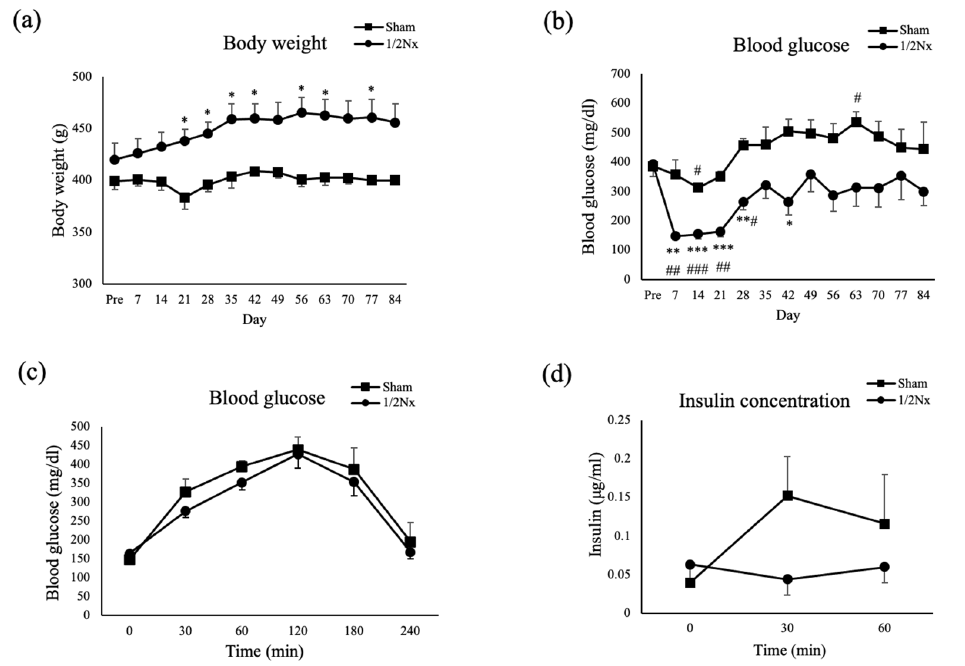
Figure 4. The changes of body weight and blood glucose after surgery and oral glucose tolerance test at 28 days after surgery. ( a , b ) Postoperative changes in ( a ) body weights and ( b ) blood glucose concentrations of Sham operated ( n = 3) and 1/2Nx ( n = 6) rats. * p < 0.05, ** p < 0.01, *** p < 0.001 between the two groups. # p < 0.05, ## p < 0.01, ### p < 0.001 compared with preoperative value in the same group. ( c , d ) OGTT results 28 days after surgery in the Sham operated ( n = 3; closed squares) and 1/2Nx ( n = 4; closed rhombi) rats. ( c ) Blood glucose level after glucose loading. ( d ) Plasma insulin level after glucose loading.